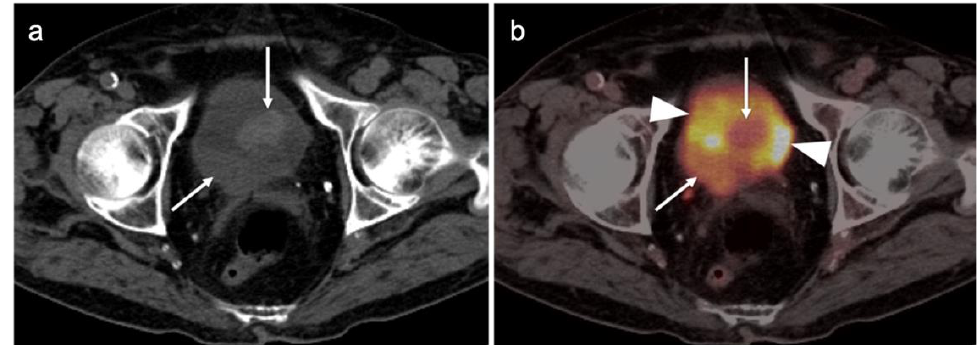
Figure 39. Lower tract urothelial carcinoma. ( a ) Axial non-contrast enhanced CT image shows a mass arising from the right posterior aspect of the urinary bladder with a lobular component extending into the bladder (white arrows); ( b ) Axial FDG PET-CT image shows that the mass in the bladder is hypermetabolic (white arrows), but lower in activity than the surrounding urine (white arrowheads).